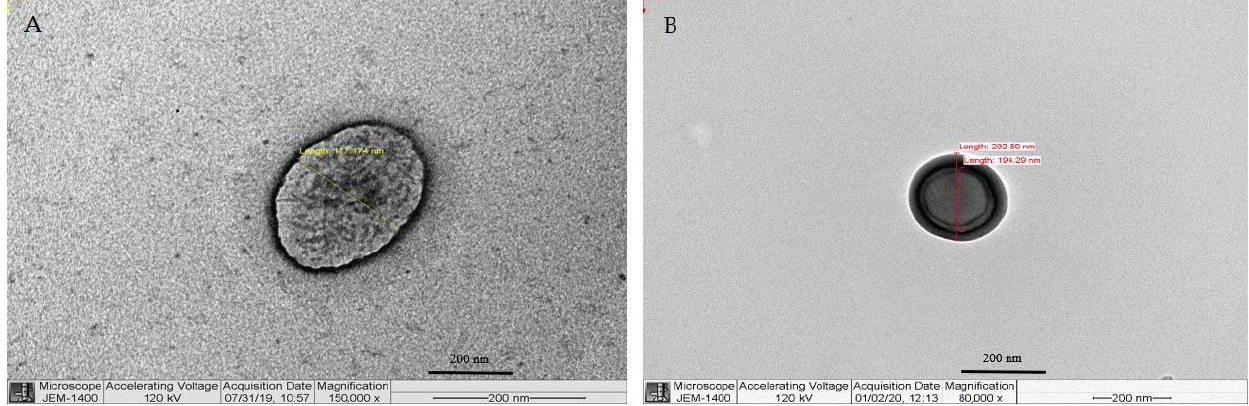
Figure 4. Transmission electron microscopy images showing the morphology of epirubicin-loaded NPs; ( A ) EPI-NPs micrograph, magnification 150,000×. ( B ) EPI-NPs micrograph, magnification 80,000×.